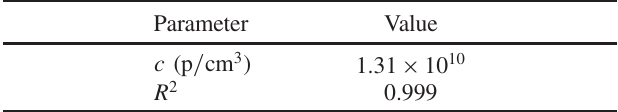
TABLE VIII. Fit parameters for the curve in Fig. 23.